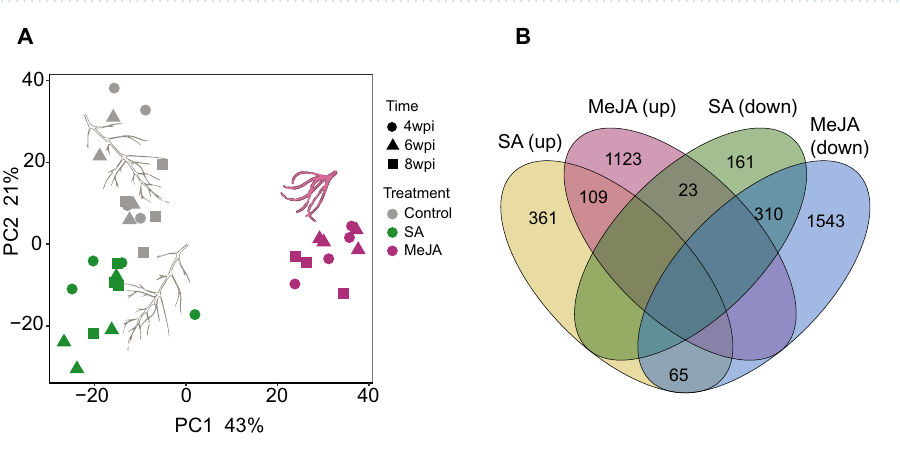
Figure 3. Effect of MeJA and SA on the biosynthesis of alkannin/shikonin (A/S) and phytohormones. ( A ) Levels of total A/S (line graph) and proportion (pie plot) of different A/S derivatives quantified in roots of L. officinale after 4 weeks post inoculation (4 wpi), 6 wpi and 8 wpi of respective treatments. ( B ) Total jasmonates (boxplot) and proportion (pie plot) of different derivatives of jasmonates. ( C ) SA in the roots of L. officinale after 8 wpi. n = 3–5 replicates for each treatment and each time point. Abbreviations: ACS, Acetyl-A/S; DOS, Deoxy- A/S; IVS, Isovaleryl-A/S, JA-Ile, Jasmonate-isoleucine; cis -OPDA, cis-Oxophytodionic acid; JA, jasmonic acid.